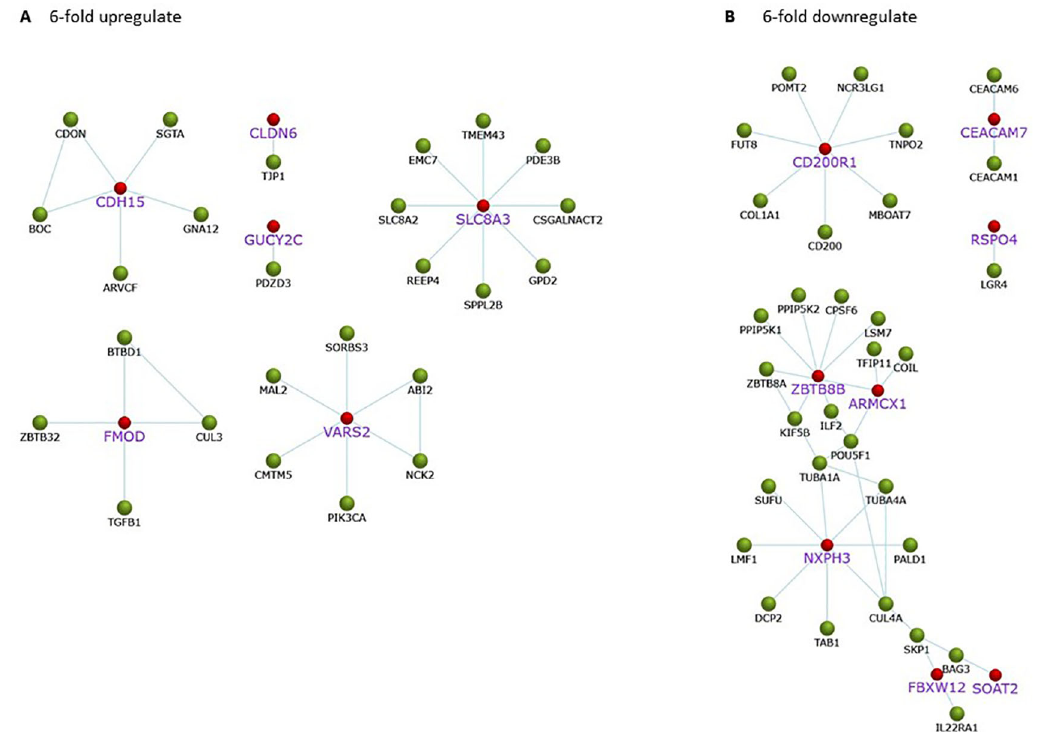
Figure4.ProteininteractionsrelatedtocanceronA549cellsafter C.sappan extracttreatmentfor24h. Thered mark for gene found upregulated or downregulated in the A549 cells after treatment with the extract. (A) 6-fold upregulate; (B) 6-fold